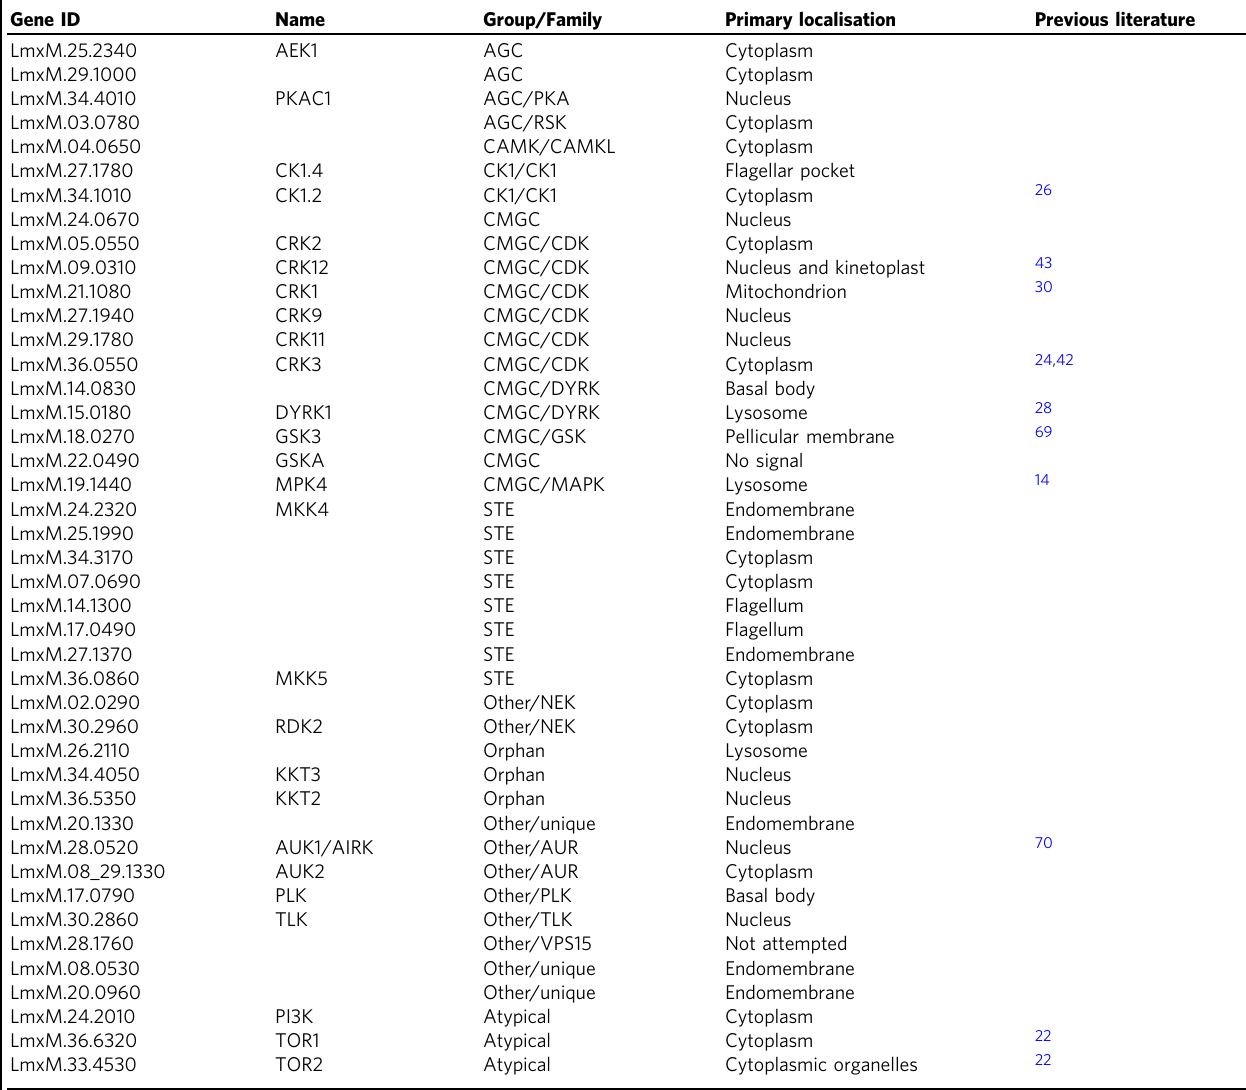
Table 1 Required L. mexicana protein kinase